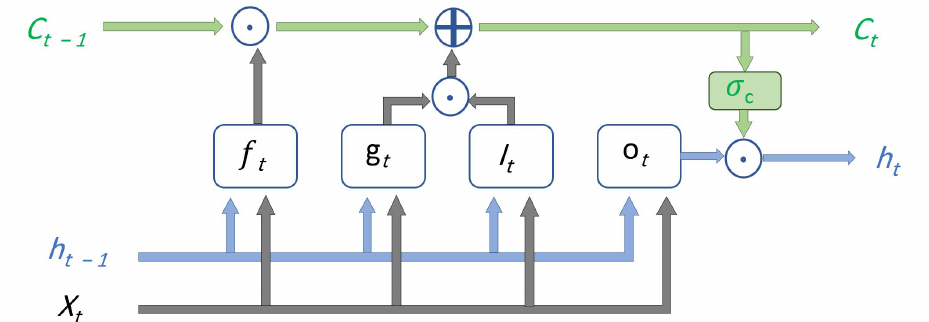
Figure 2. A basic structure of LSTM